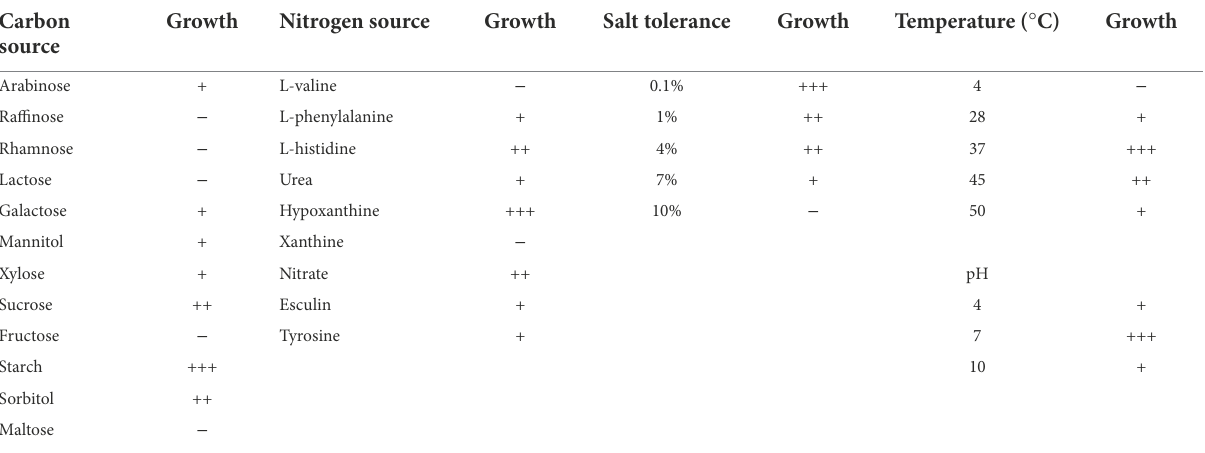
TABLE 1 Differential physiological properties of Saccharopolyspora rosea A22.